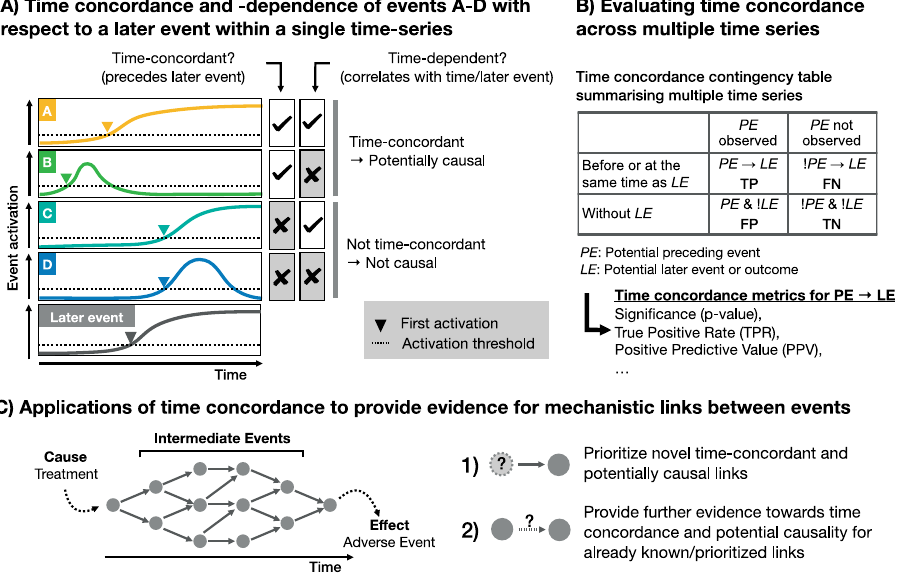
Fig 1. Quantifying time concordance based on first activation. (A) The event activation of the events A-D and the later event is shown over time, as well as their timepoint of first activation, at which the event first passes the defined activation criteria. If an event takes place before a defined later event, which in our study is adverse histopathology, it is time-concordant. Time concordance indicates that there is potentially a causal relation between both events, and is distinct from time-dependence which is defined based on the correlation to the later event or time. (B) Based on the frequency of an event before or at the same time as the later event and its frequency in background time-series without the later event, a confusion matrix and different time concordance metrics can be derived. (C) Time concordance can both prioritize novel links and provide further evidence on potential mechanistic links between events. Events are indicated as nodes and mechanistic links between them as